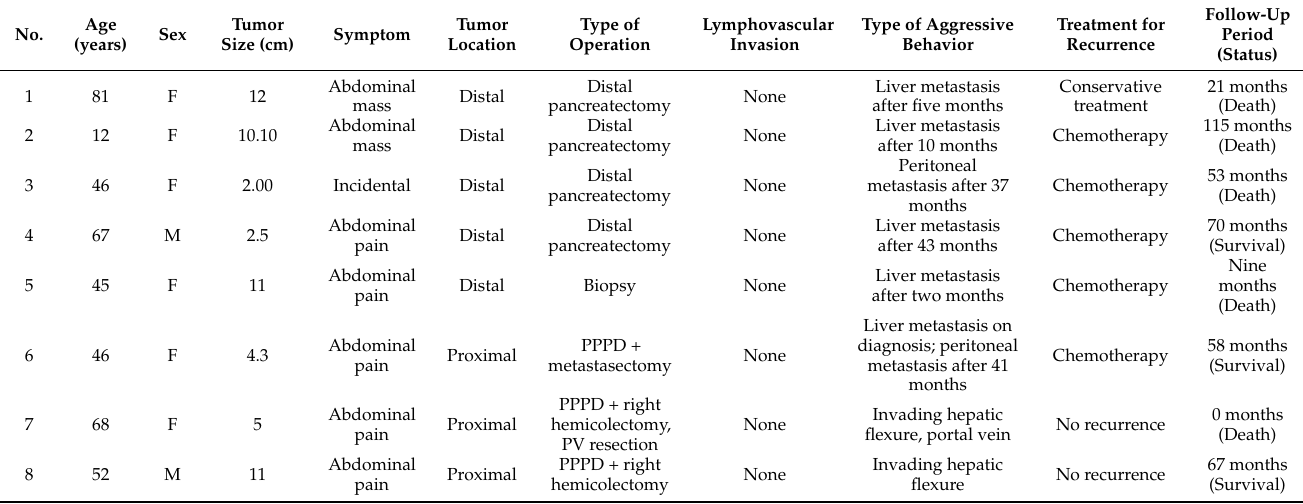
Table 4. Profile of the patients with aggressive solid pseudopapillary